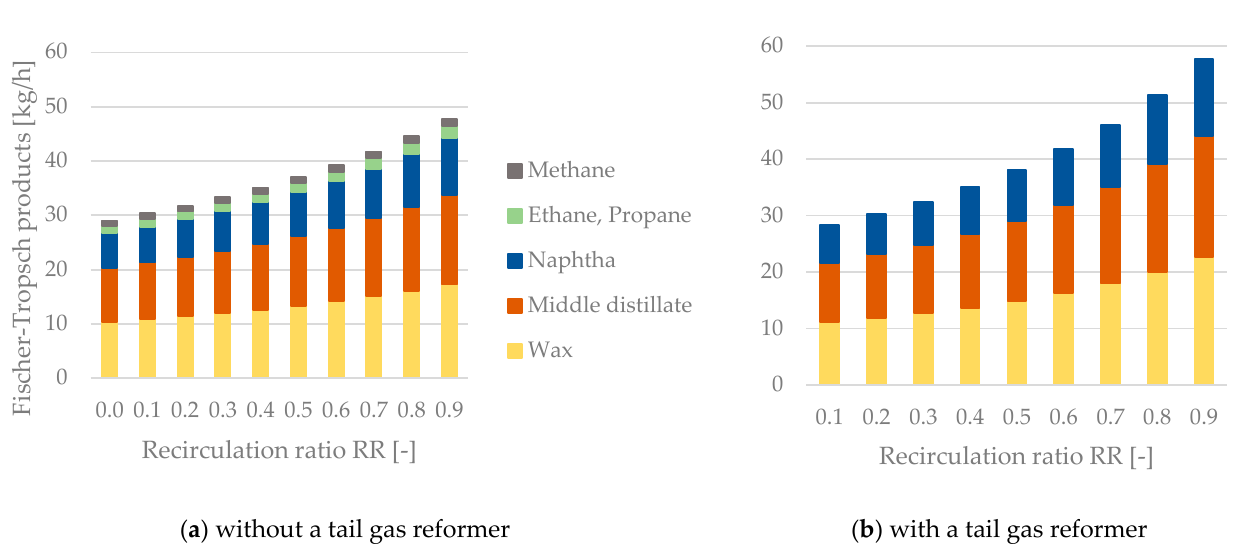
Figure 7. Fischer-Tropsch products as a function of the recirculation ratio RR—( a ) process configuration without a tail gas reformer, ( b ) process configuration with a tail gas reformer.